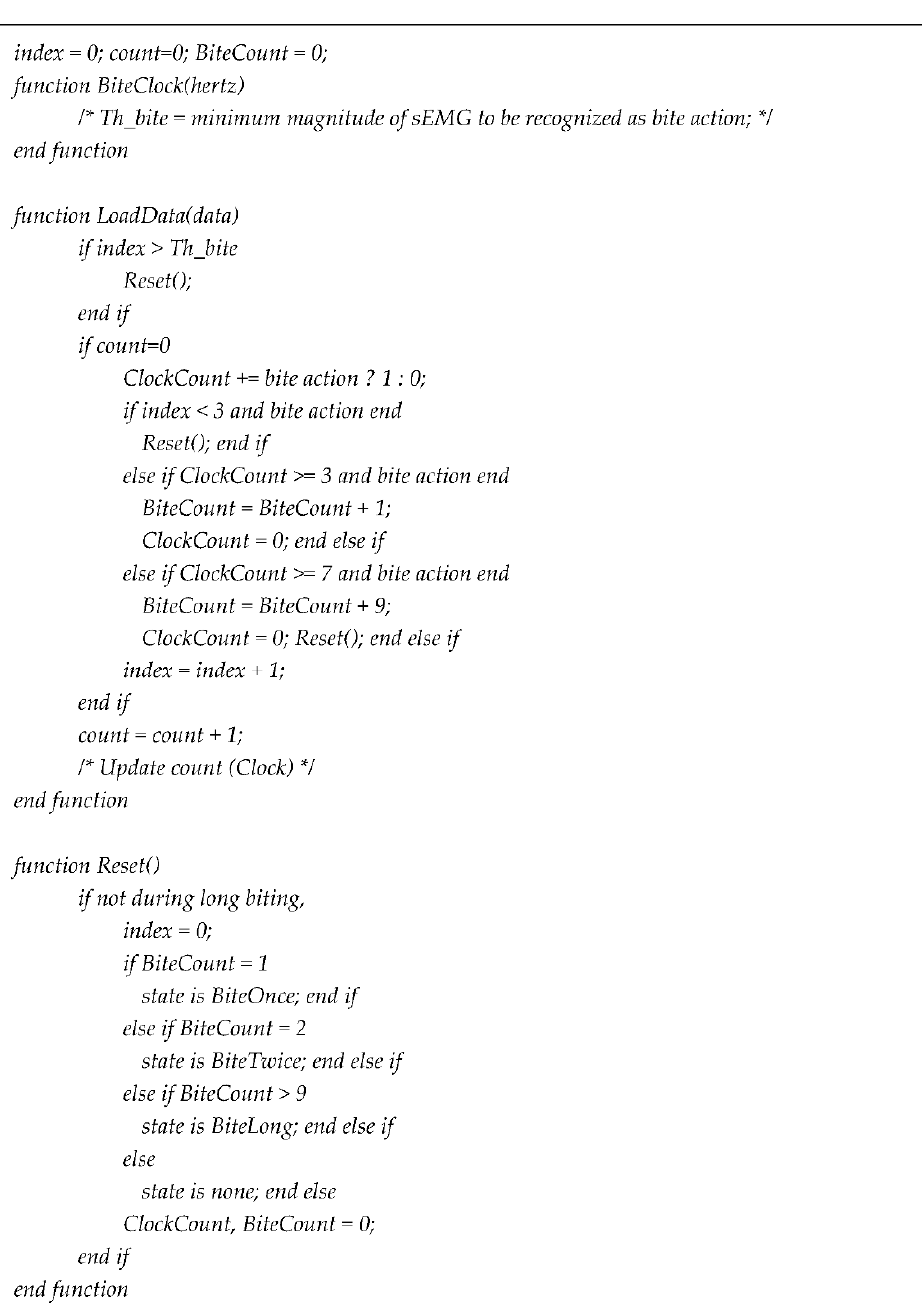
Figure 9. Pseudo codes for classification of biting inputs.